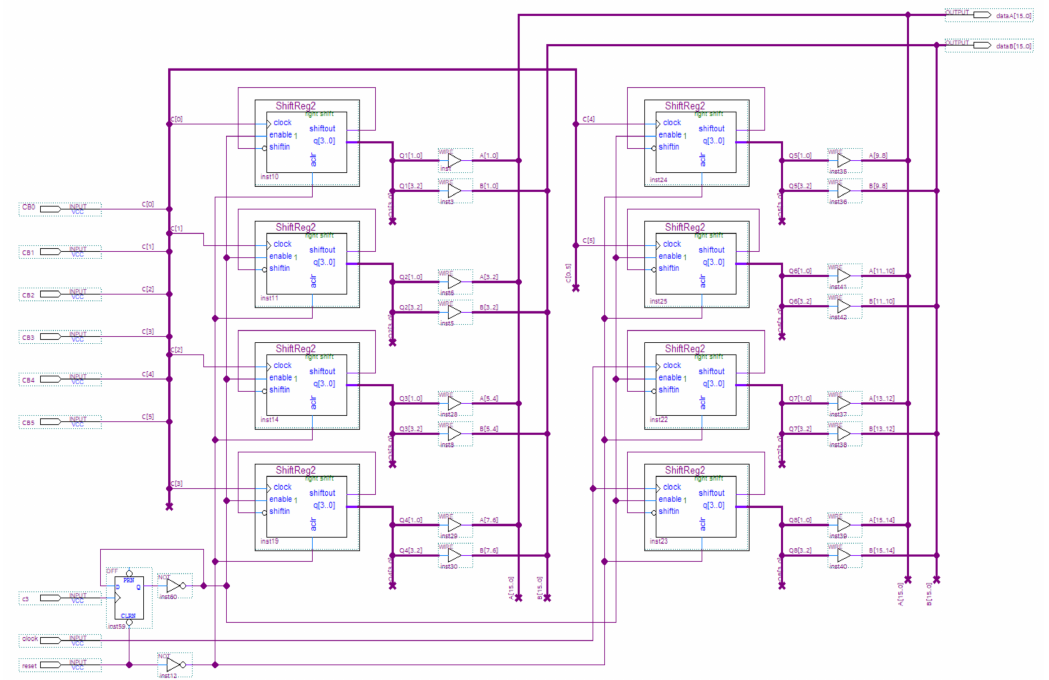
Figure 5. The OpUnit subcircuit for n =